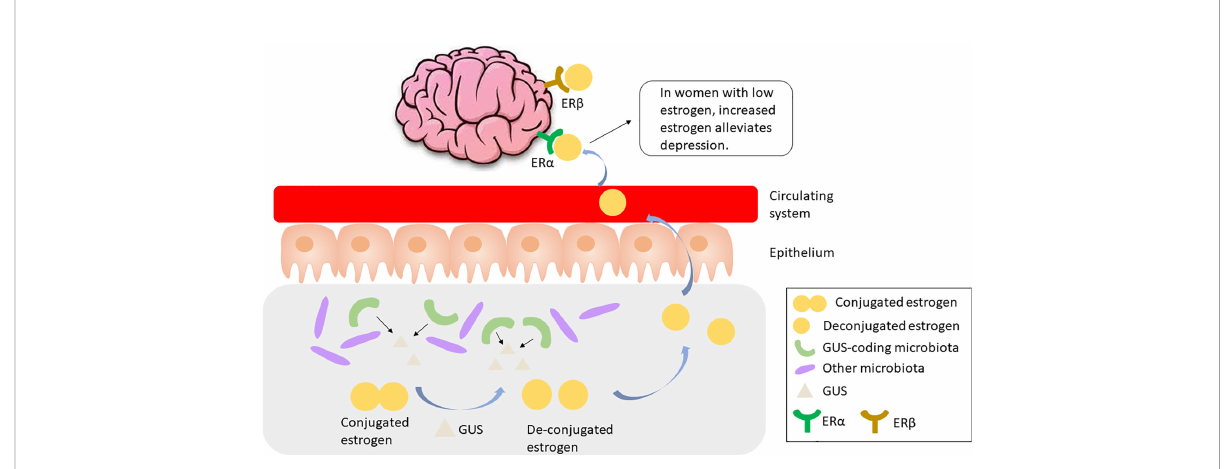
FIGURE 2 GUS-coding microbiota produces GUS to cleave and activate conjugated estrogen, which is released to the circulating system and binds to ER a , resulting in alleviated depression in women with low estrogen. GUS, b -glucuronidase; ER, estrogen